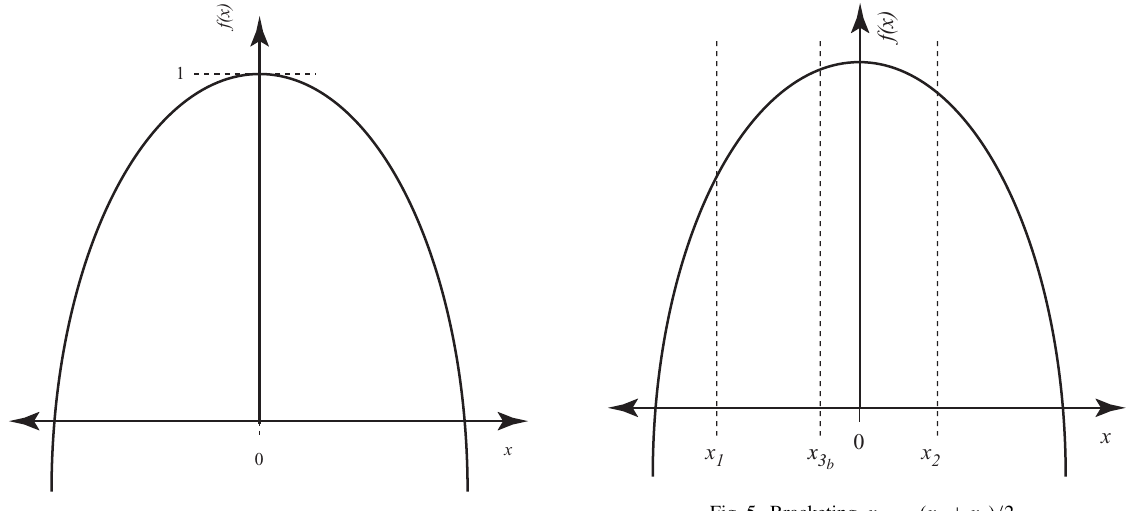
Fig. 5. Bracketing, x 3